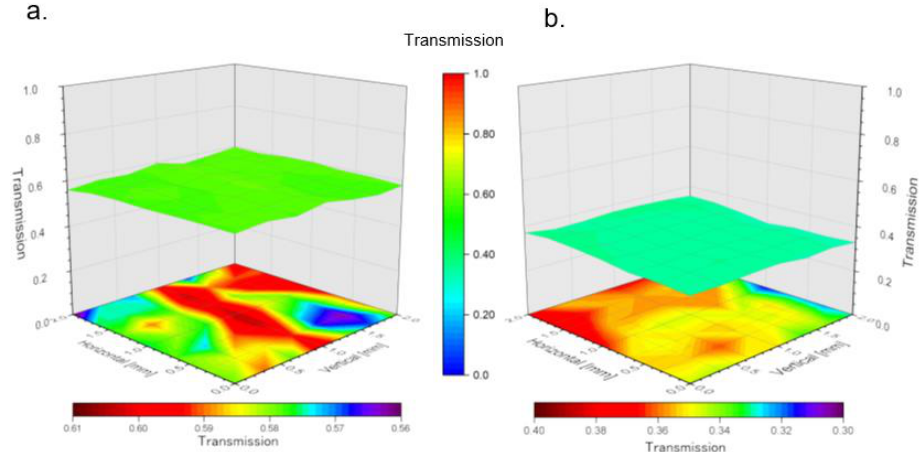
Figure 3. Transmissions of the normal tissue with widths of ( a ) 100 µ m and ( b ) 200 µ m in terahertz imaging. Each graph illustrates the transmission data for 7 × 7 points in 2 mm 2 using the three- dimensional and two-dimensional hue maps.